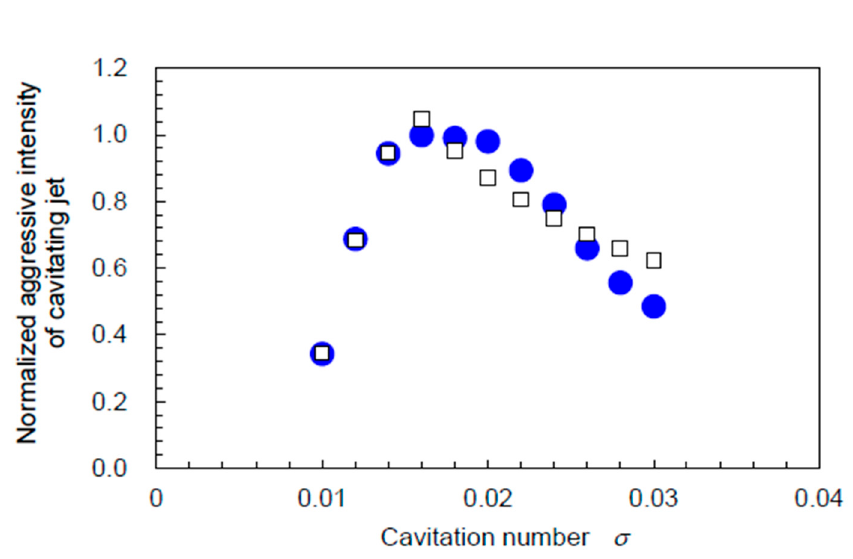
Figure 21. Aggressive intensity of cavitating jet changing with cavitation number.